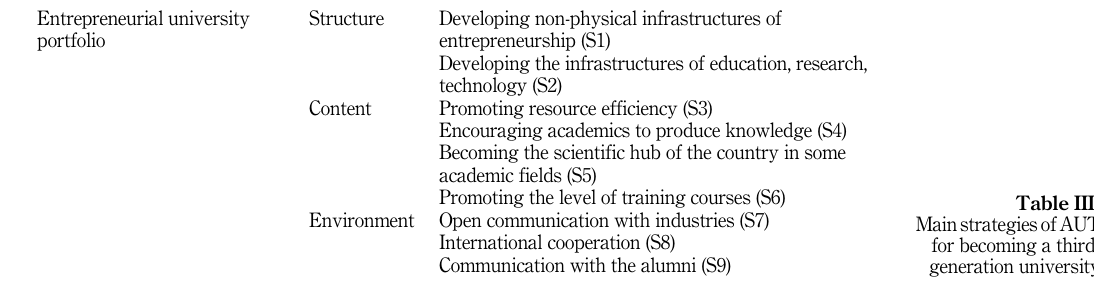
Table III. MainstrategiesofAUT